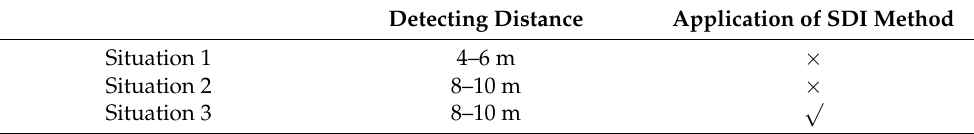
Table 1. Description of simulation